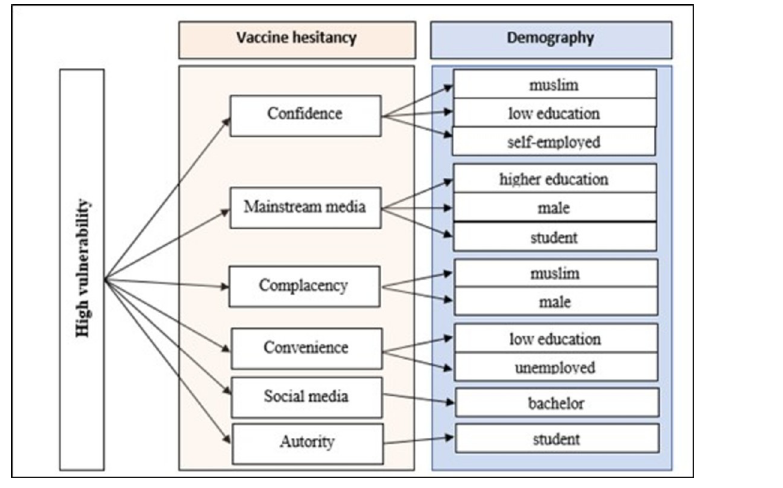
Fig 4. Groups with a high level of vulnerability based on demographic